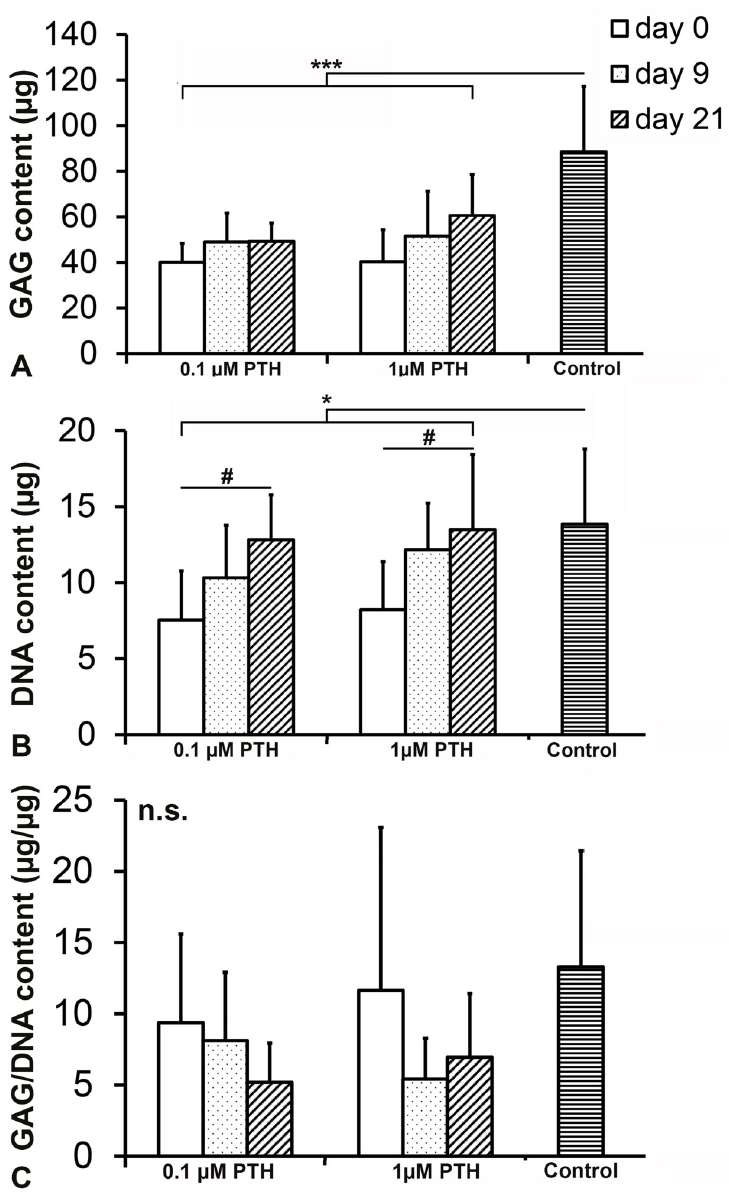
Fig 4. GAG, DNA and GAG/DNA content of human chondrocytes cultured for 28 days in the presence of 0.1 or 1.0 μ M PTH from day 0, 9 or 21 onwards. Controls did not receive PTH. (a) PTH treatment resulted in a lower GAG content (p = 0.001). (b) DNA content was decreased by addition of 0.1 and 1.0 μ M PTH ( � : p = 0.030). A time- dependent increase in DNA content was observed in the presence of PTH (#: p = 0.027), with no difference between 0.1 and 1.0 μ M. (c) GAG/DNA content did not differ between conditions. n.s.: not significant. Graphs show mean ± 95% C-I. n =